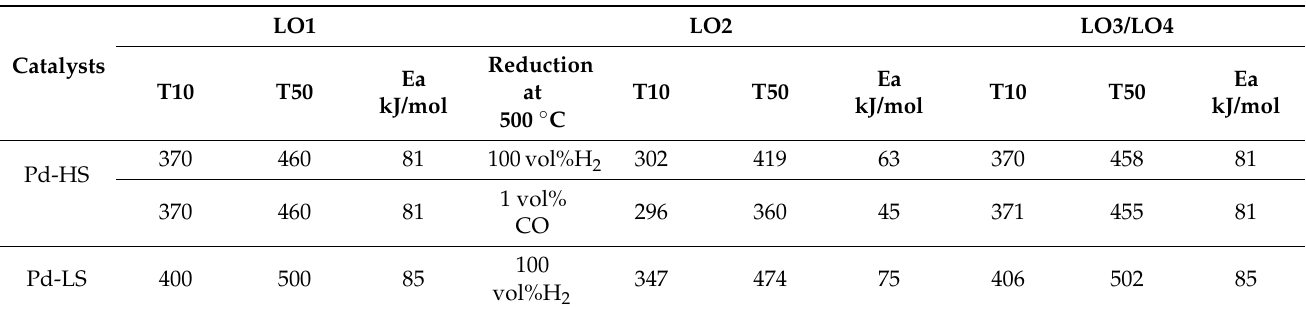
Table 5. Catalytic properties for propane